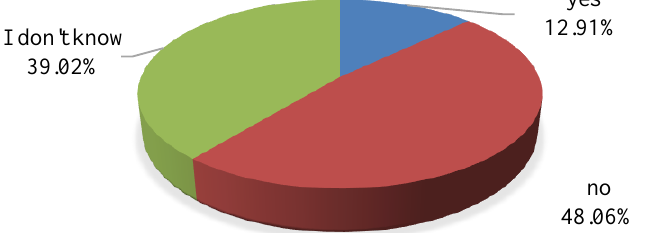
Figure 16. Was there an energy audit conducted in the residential building?